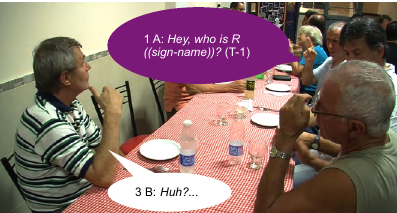
Figure 6. ‘Huh? , Person B (left) initiates repair on Person A’s previous turn by raising his eyebrows and head first, line 3.